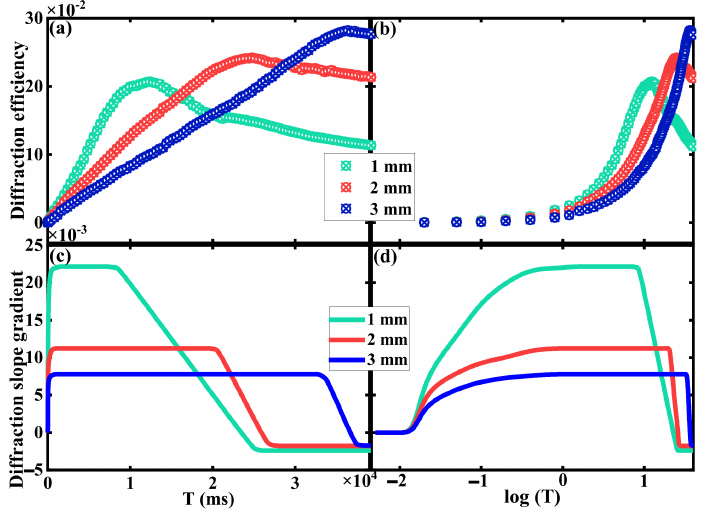
Figure 5. Temporal diffraction characteristics of HRE by ms level exposure with ( a ) linear abscissa (T), ( b ) logarithmic abscissa (log(T)), and the diffraction slope gradient with ( c ) linear abscissa (T) and ( d ) logarithmic abscissa (log(T)).